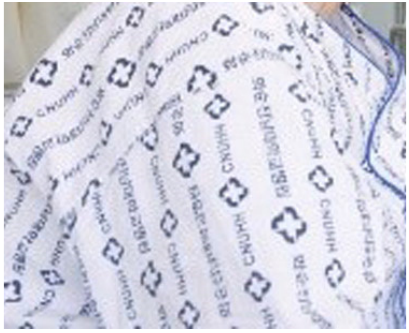
Figure 1. Striped pattern for patient clothing .